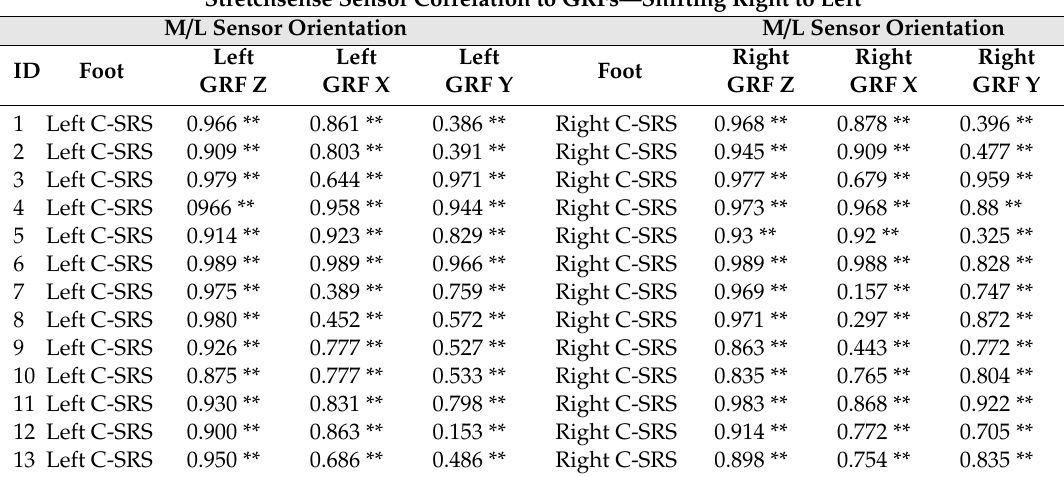
Stretchsense Sensor Correlation to GRFs—Shifting Right to Left